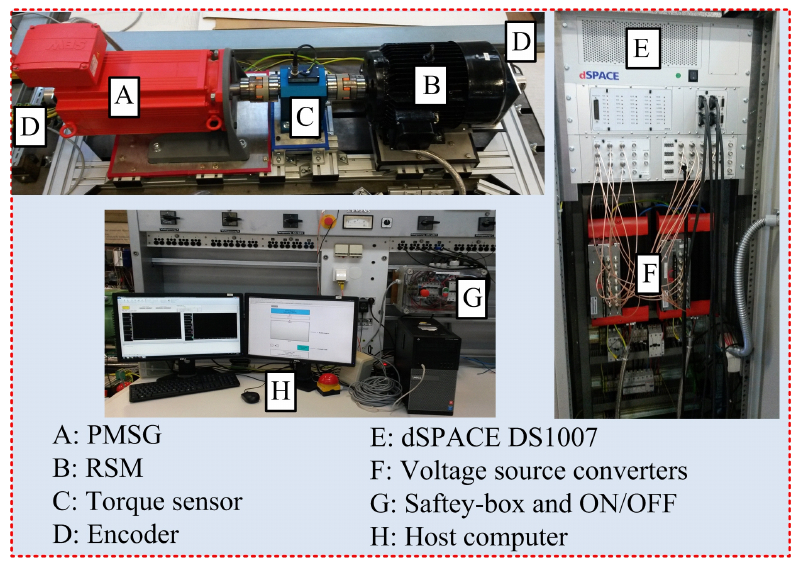
Figure 7. Test bench utilized to validate the proposed DB-PC